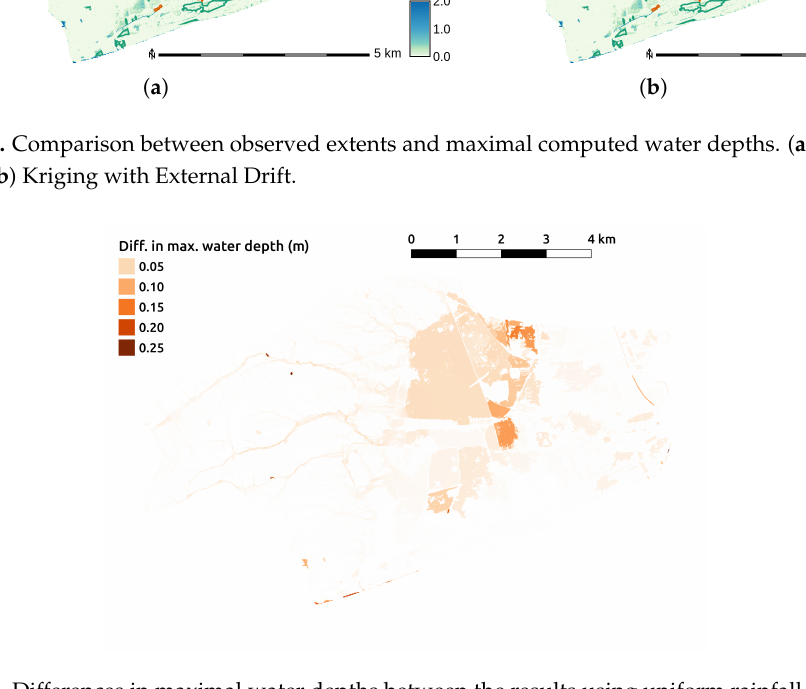
Figure 11. Differences in maximal water depths between the results using uniform rainfall and those using Kriging with External Drift.